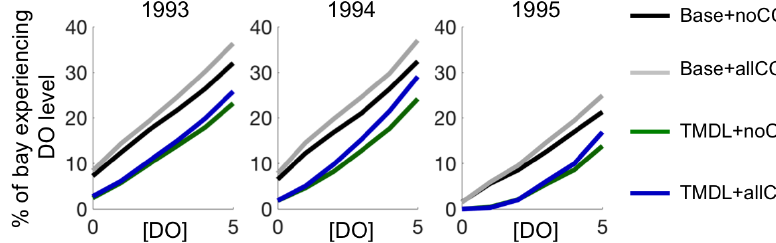
Figure 9. Percent of the entire bay that experiences a given DO level during 1993, 1994, and